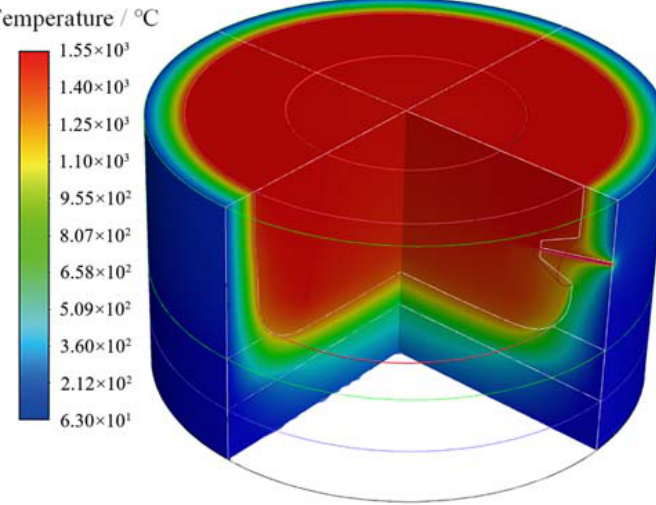
Figure 5. The temperature distribution of the normal production model. The streamline of hot iron inside the hearth is shown in Figure 6. Because the porosity of the deadman is small, the hot iron was prevented from flowing inside the deadman. Most of the hot iron flows through the periphery and the bottom of the deadman to form a circulation phenomenon. In addition, almost no hot iron flowed through the local depressed erosion area. This indicates that the solidified iron protective layer had formed in this area under the current production conditions.